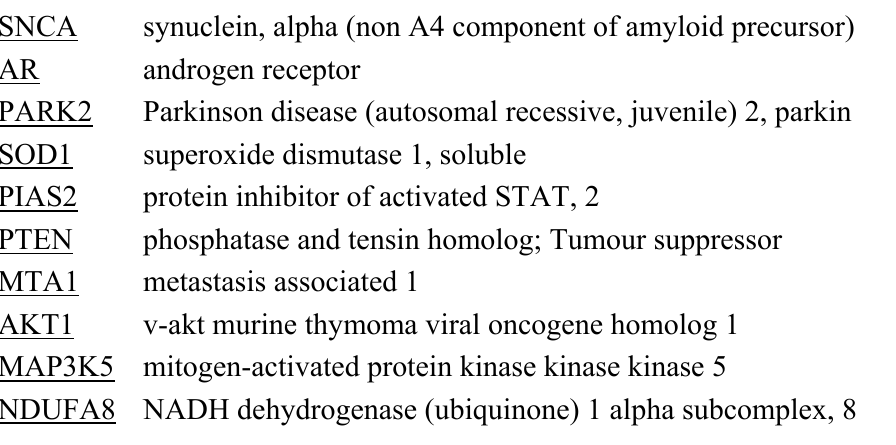
PARK7 acts as a positive regulator of androgen receptor- dependent transcription, prevents aggregation of SNCA, protects neurons against oxidative stress and cell death and potentially functions as a redox-sensitive chaperone and as a sensor for oxidative stress. Figure generated by STRING v9.1